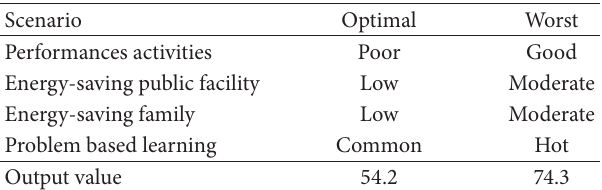
Table 5: Output values of Case 1 and Case 2 from FLIS